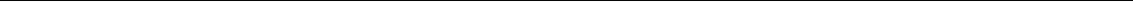
Fig. 1 Measuring RNA-ligand binding by structure probing and deep sequencing. a RNA undergoes structure changes upon ligand binding. This structural change is detected by the double-strand speci fi c nuclease, RNase V1, which cuts at different double-stranded places along the RNA in the presence and absence of the ligand. The cleavage sites are then captured and cloned into a cDNA library for deep sequencing. After mapping the reads to the transcriptome, we can identify which bases have undergone changes in structuredness upon ligand binding (highlighted in beige boxes). b Deep sequencing reveals structure changes of a known TPP riboswitch, thiM, using RNase V1 (top), S1 nuclease (middle), and in-line probing (bottom). The red and black lines indicate the structure pro fi les of thiM treated with and without 100 µ M TPP, respectively. The beige regions highlight regions of structural changes upon ligand binding. c PARCEL identi fi ed 85% of known TPP, FMN, and SAM riboswitches in B . subtilis and P . aeruginosa . The black and the white bars indicate the number of known riboswitches that were captured and missed in our study, respectively. d PARCEL sequencing data for the B . subtilis TPP riboswitch, thiT, in the presence and absence of 100 µ M TPP (top), 100 µ M thiamine (middle), and 100 µ M oxythiamine (bottom). PARCEL detected strongest structural change in thiT in the presence of TPP, followed by thiamine and then oxythiamine, which corresponds to the binding af fi nities of TPP riboswitches for these metabolites 9 . e The plots show normalized V1 read counts of the thiC TPP riboswitch under increasing concentrations of TPP. PARCEL was performed on the B . subtilis